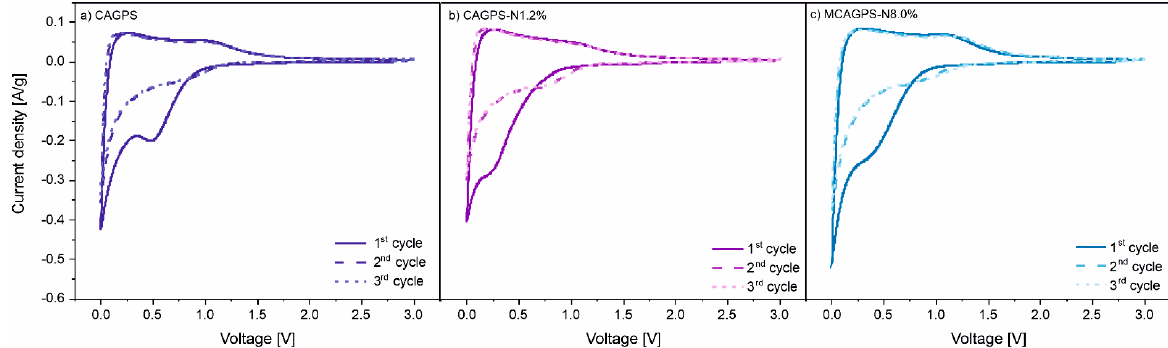
Figure 5. Cyclic voltammetry curves of ( a ) CAGPS-, ( b ) CAGPS-N1.2%-, and ( c ) MCAGPS-N8.0%-based cells (MCAGPS— carbon aerogel made from potato starch modified with melamine; CAGPS-N—carbon aerogel made from potato starch modified by N 2 pyrolysis; CAGPS—pristine carbon aerogel).